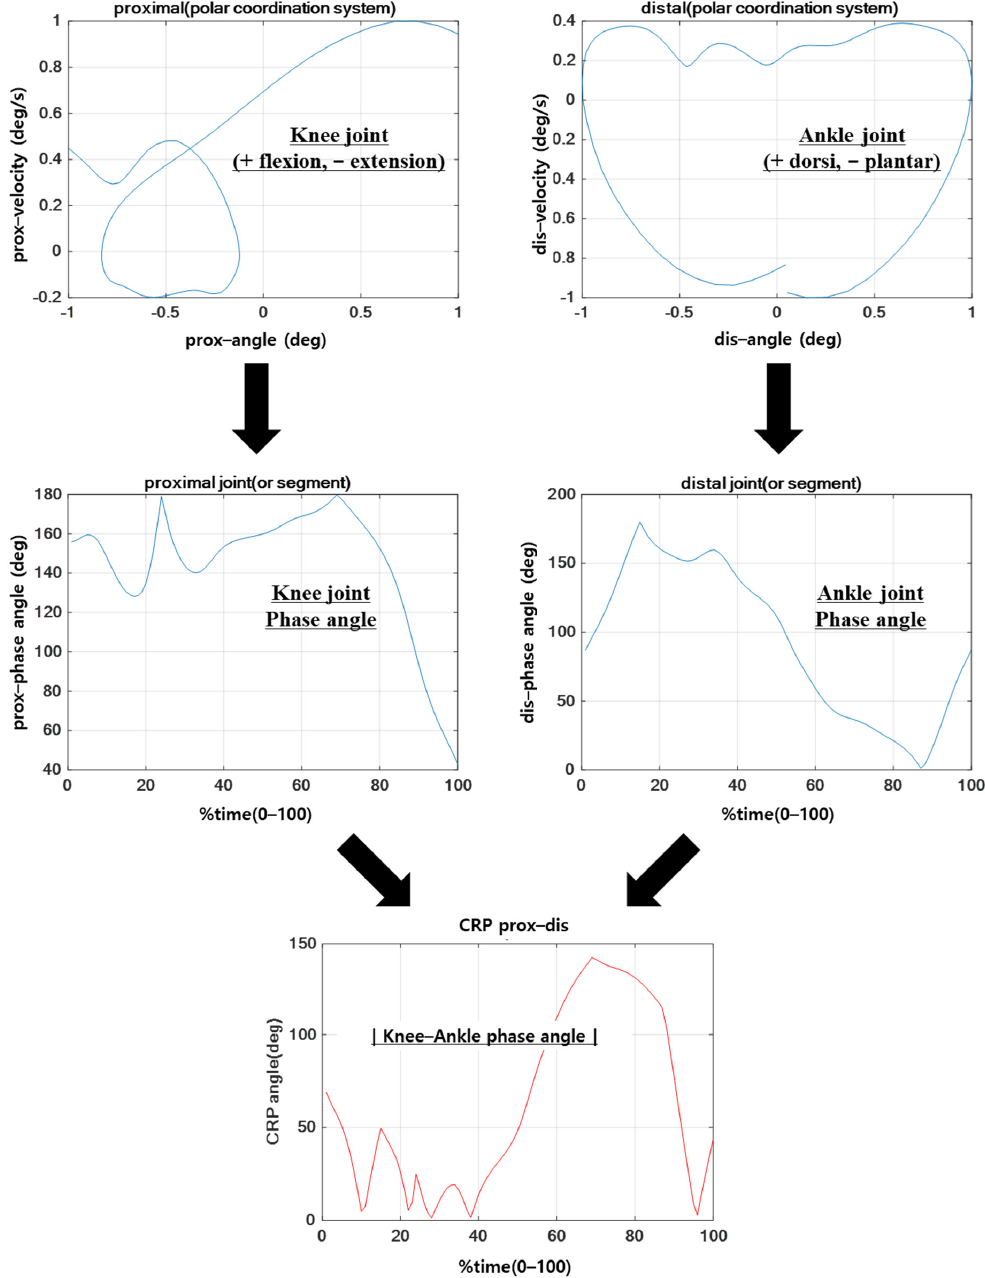
Figure 3. Procedure of continuous relative phase (CRP) data processing (the 1st row = each joint angular displacement and velocity on polar coordination system, the 2nd row = each joint phase angles, the 3rd row = CRP angle).